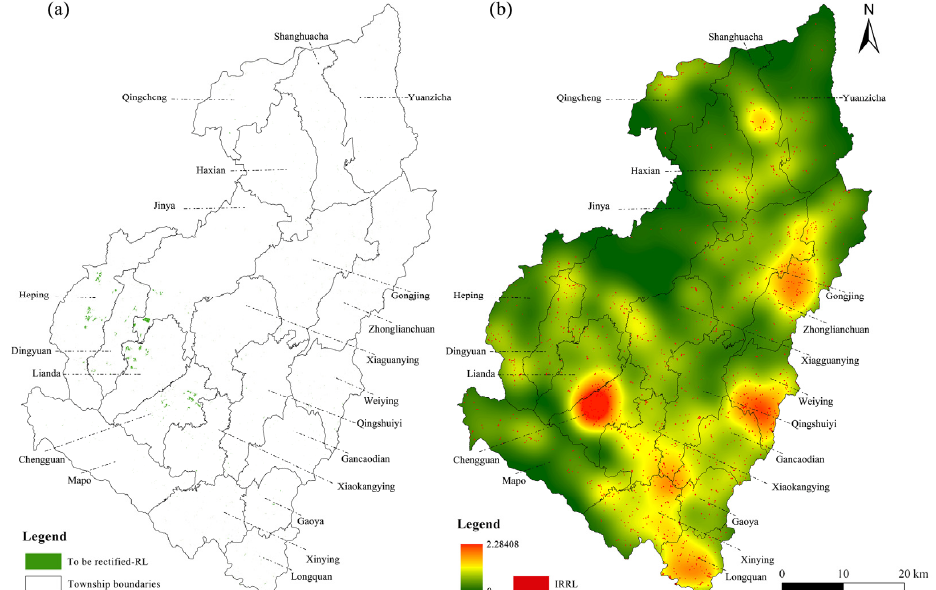
Figure 5. The spatial distribution of the idle residential land in Yuzhong County: ( a ) the spatial distribution of the idle residential land; ( b ) the kernel density analysis of the idle residential land.